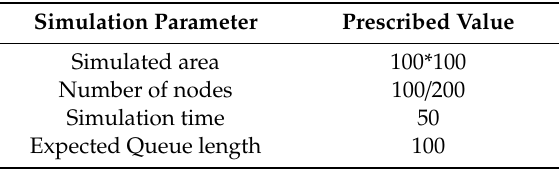
Table 2. Table of simulation